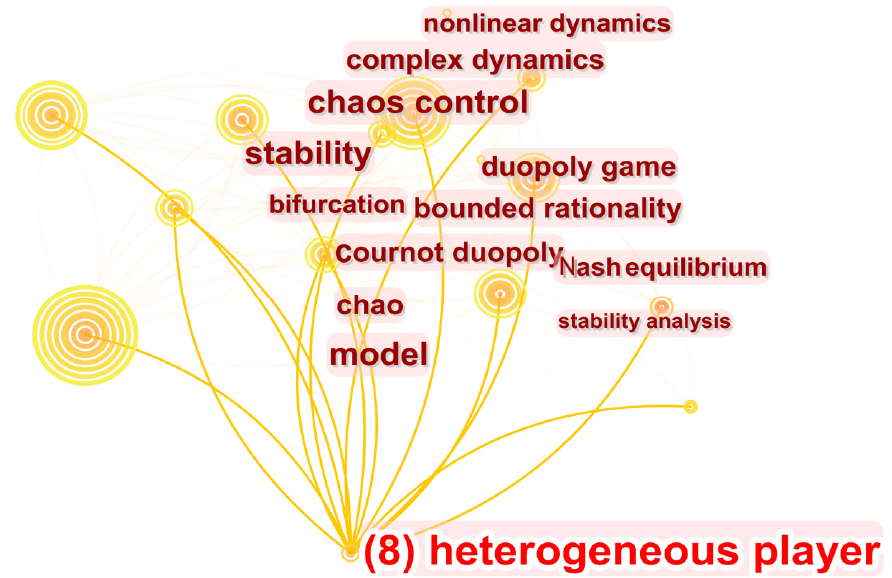
Figure 7. “Heterogeneous player” and its co-occurrence key words.